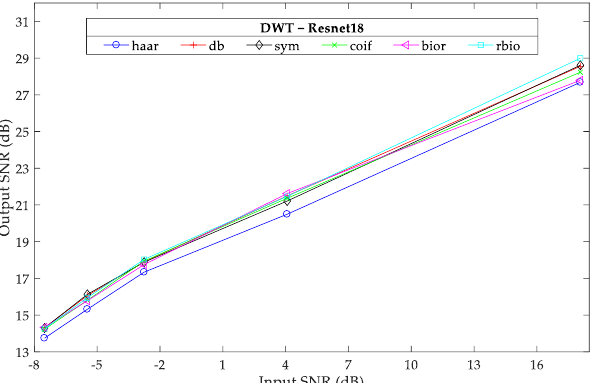
Figure 2. Trend of the best denoising results of DWT−Resnet18 with varying SNRs of noisy seismic data under different wavelet basis functions.